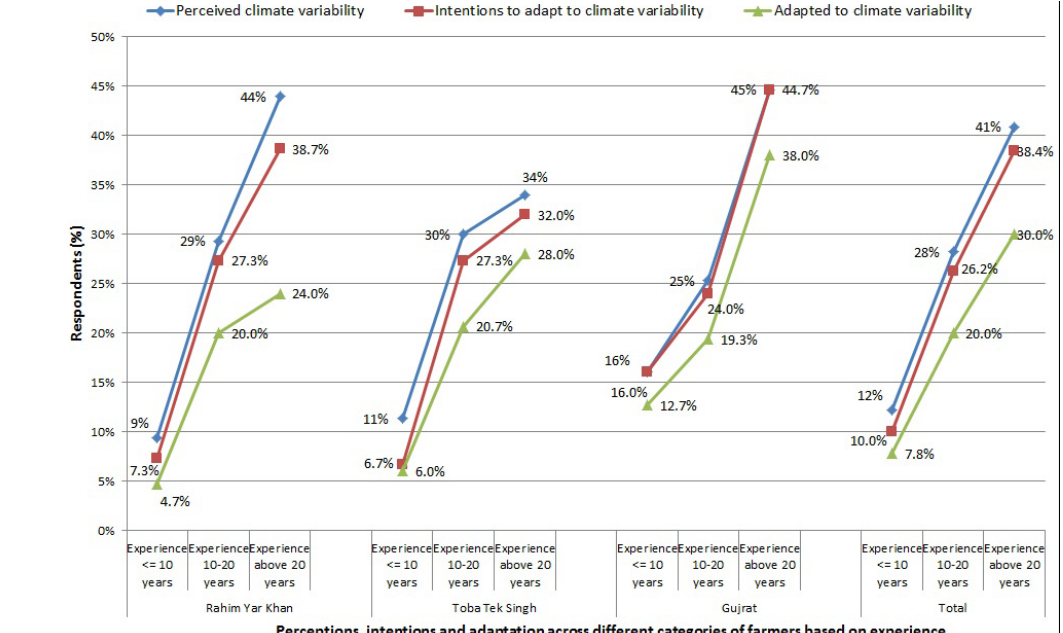
Figure 8. Perceptions, intentions and adaptation to climate change across different categories of farmers on farming experience in